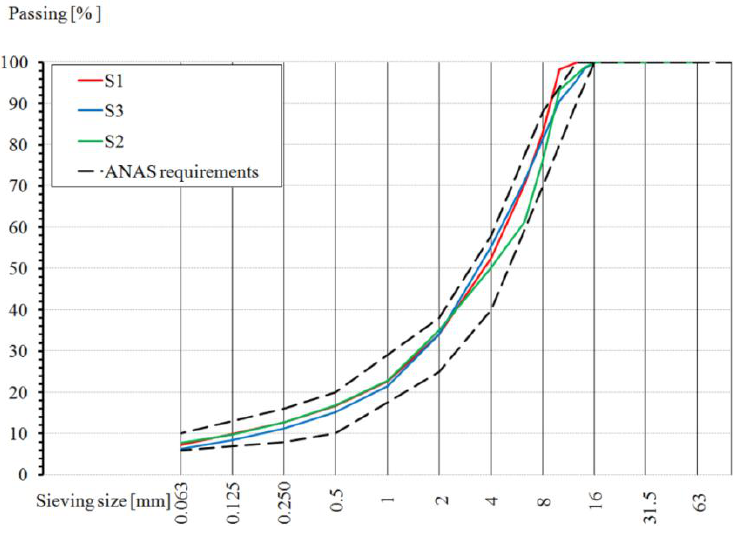
Figure 2. Mixtures grading curve of hot mixed asphalts (HMAs) correlating with (Azienda Nazionale Autonoma delle Strade (Italian National Roads